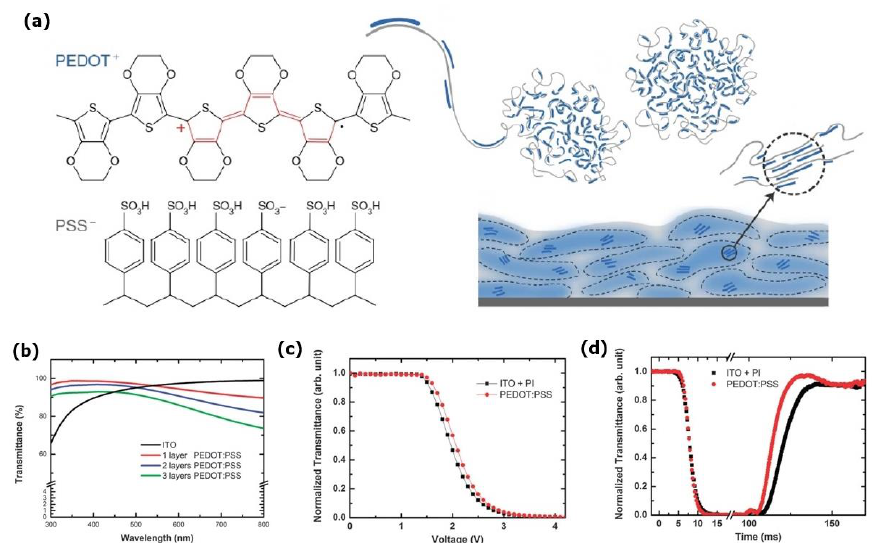
Figure 5. ( a ) Chemical structure of PEDOT:PSS, which is solution processed in water via the formation of gel particles. The resulting polymer film of PEDOT:PSS-rich regions and PSS-rich regions on a substrate forms a transparent conductive layer. The conductivity is enhanced by the crystalline PEDOT:PSS regions. (Reproduced by permission from ref. [56]). ( b – d ) show the optical and electro-optical performance of a liquid crystal cell compared between an ITO and polyimide coated glass substrate versus a PEDOT:PSS electrode layer. While the transmittance performance of the PEDOT:PSS electrode is outperformed in the visible optical region by the ITO electrode ( b ), the switching characteristics ( c ), as well as the switching dynamics ( d ) of the respective liquid crystal devices are quite similar. (Reproduced by permission from ref.